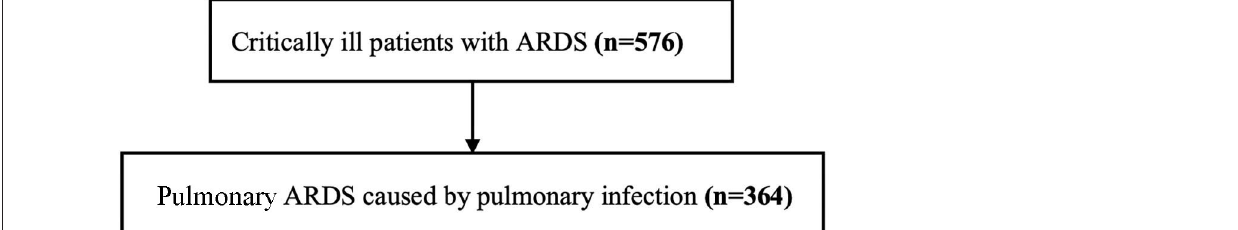
CD4 + T cell subgroups, CD8 + T cell subgroups, B cells (CD19 +